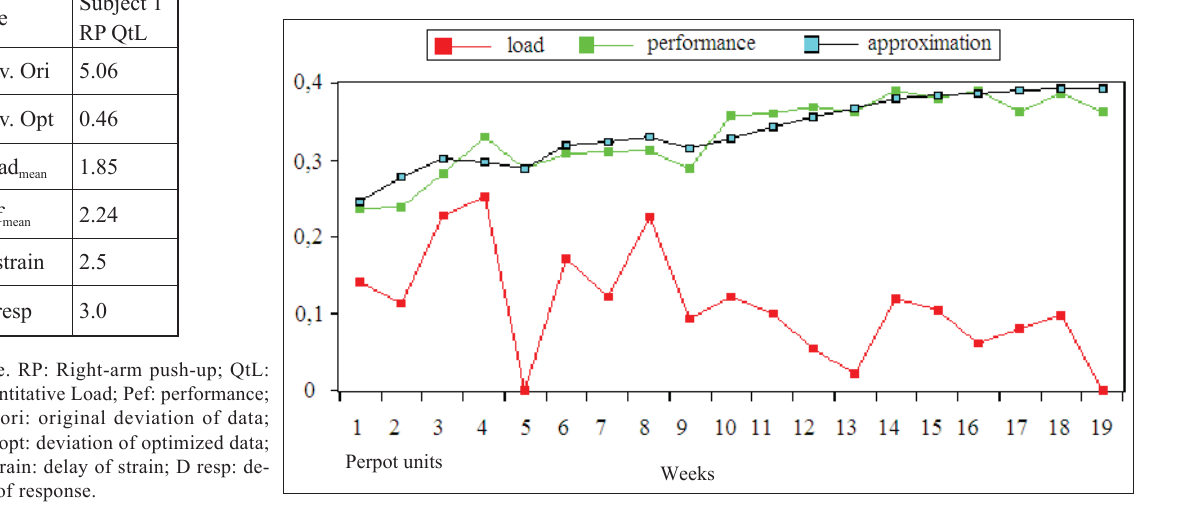
Fig. 1. Performance of right push-up and quantitative load interaction by means of Perpot Metamodel of Subject 1